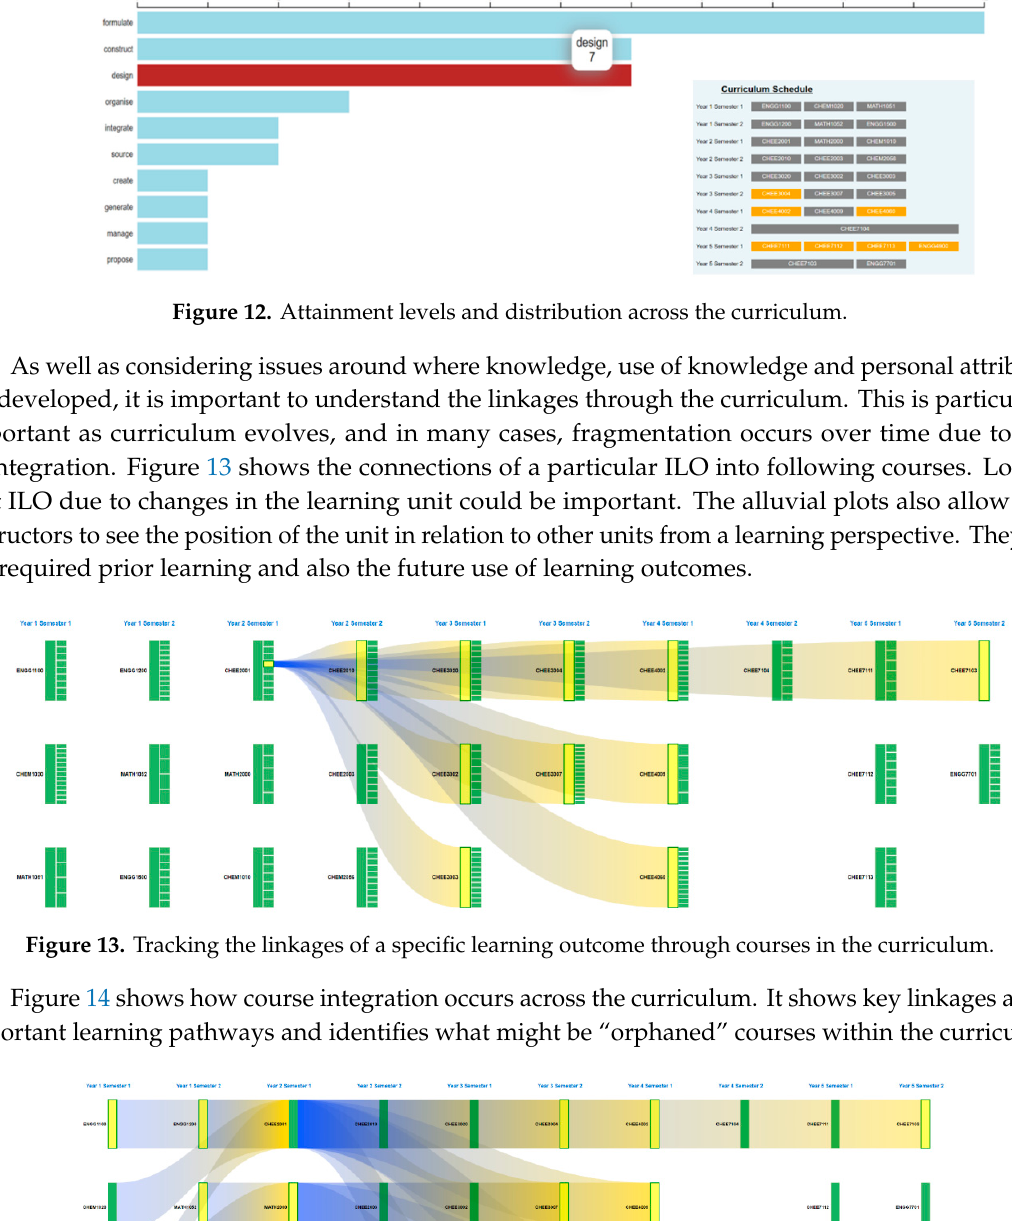
Figure 12. Attainment levels and distribution across the curriculum.